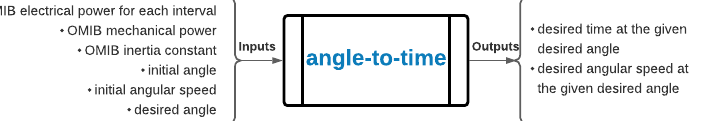
Figure 14. Schematic representation of angle-to-time function to find the time and angular speed associated with a desired angle.